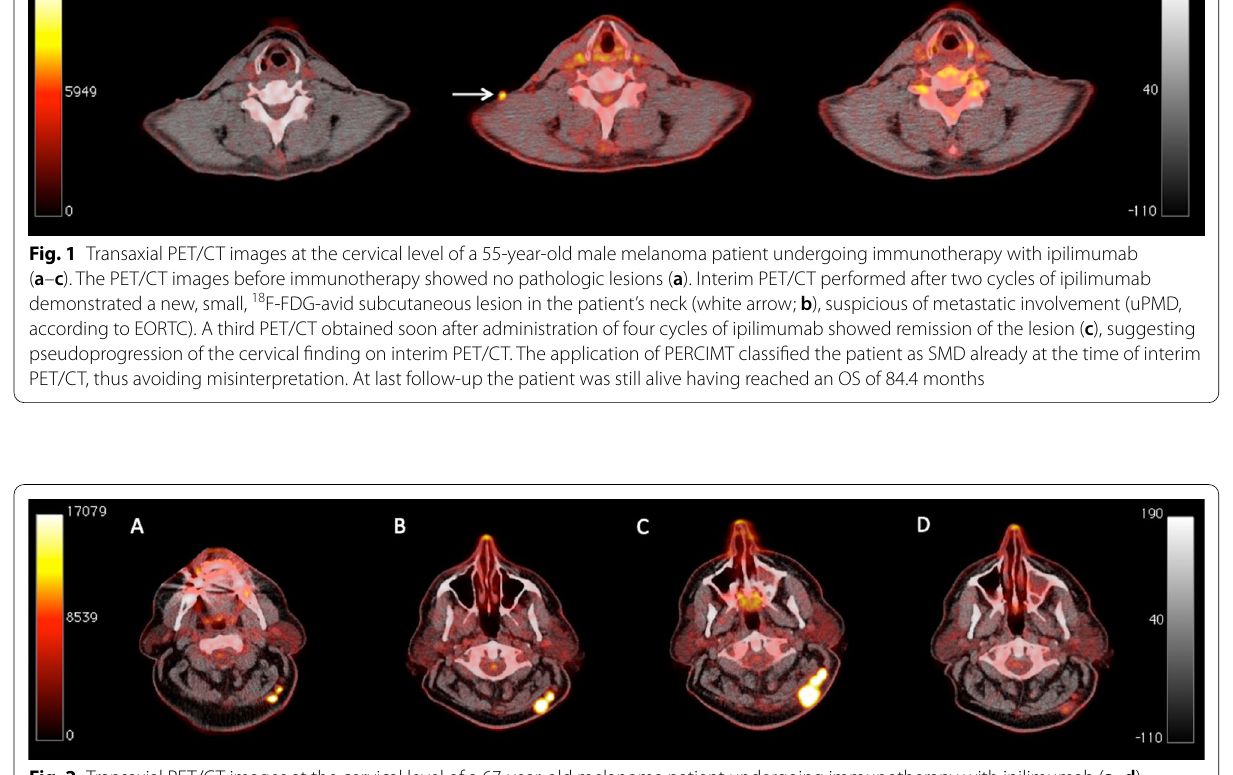
Fig. 2 Transaxial PET/CT images at the cervical level of a 67‑year‑old melanoma patient undergoing immunotherapy with ipilimumab ( a – d ). Baseline PET/CT before commencement of therapy showed two hypermetabolic, subcutaneous metastases in the patient’s neck with SUV max reaching 21.2 ( a ). After two cycles of ipilimumab, an increase in size and metabolism of the metastases was observed (SUV max 28.8), leading to uPMD according to EORTC ( b ). The patient received two more cycles of ipilimumab and was re‑examined with PET/CT, which demonstrated persistence of the hypermetabolic disease (SUV max 25.5) and a further increase in lesions’ size ( c ). No further treatment was administered and, 4 months later, PET/CT demonstrated a marked morphologic and metabolic (SUV max 4.2) remission of the lesions ( d ). Similar to the patient in Fig. 2, the application of PERCIMT classified the patient as SMD, thus tackling the phenomenon of pseudoprogression. At last follow‑up the patient was still alive having reached an OS of 66.7